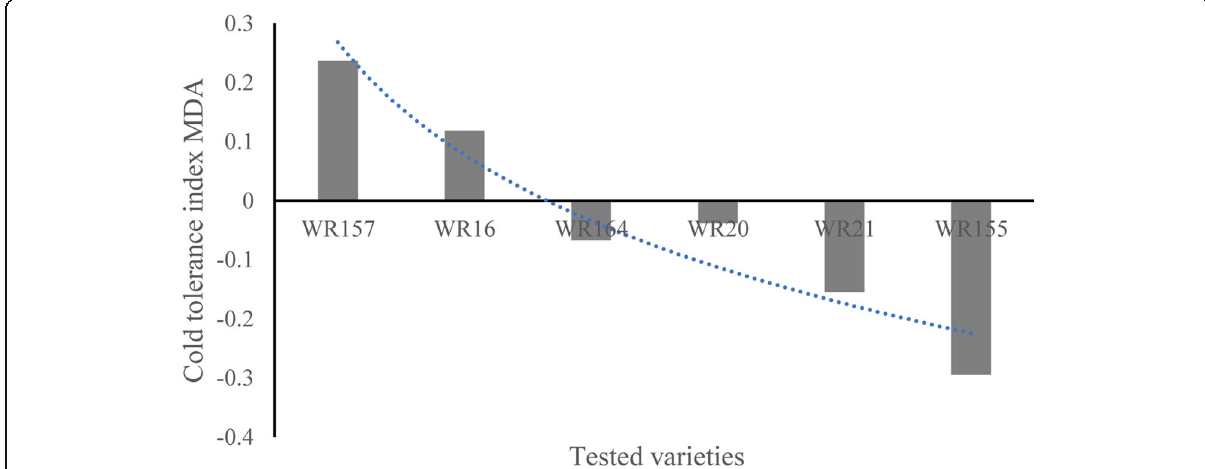
Fig. 3 MDA changes in six select weedy rice varieties. The changes in malondialdehyde (MDA) value are shown along with the cold-tolerance capacity of different varieties. The positive value represents a relative increase compared with the control group (untreated group), and the negative value represents a relative decline compared to the control group (untreated group)